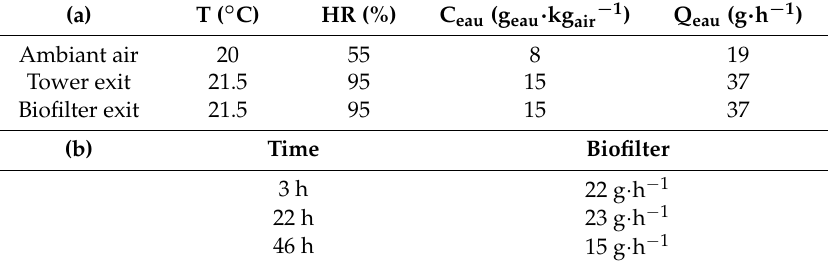
Table 1. ( a ) Air temperature and relative humidity at the different localizations in the pilot unit, airborne water concentration calculated using Mollier diagram and airborne water flow corresponding to the airflow (2 m 3 · h − 1 ). ( b ) Quantity of water exiting the biofilter through time after the tower stoppage, calculated using airborne water mass balance between the bottom and the top of the